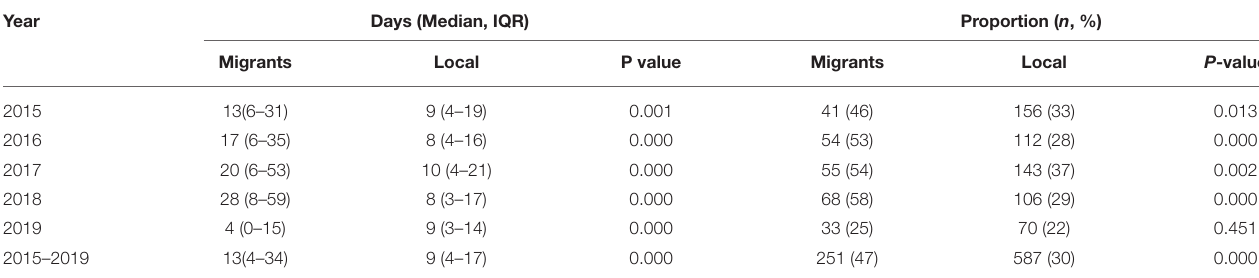
TABLE 3 | Patient delay of migrant and local patients with TB from 2015 to 2019.